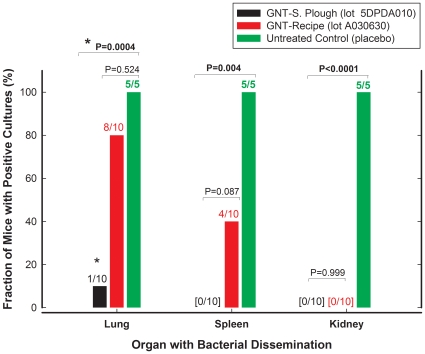
Bacterial dissemination to distant vital organs during survival experiments.After the fourth day of treatment (same experimental design described in Figure 4) the animals that survived were euthanized and their thighs, lungs, spleens and kidneys processed for bacterial counting (mice found dead were processed immediately). Although thigh counts are not illustrated in the graph, GNT-Recipe left >100,000 CFU/thigh in 80% of the animals, not different from placebo treatment (100%), but significantly different from GNT-S Plough, the innovator product (P<0.0001).